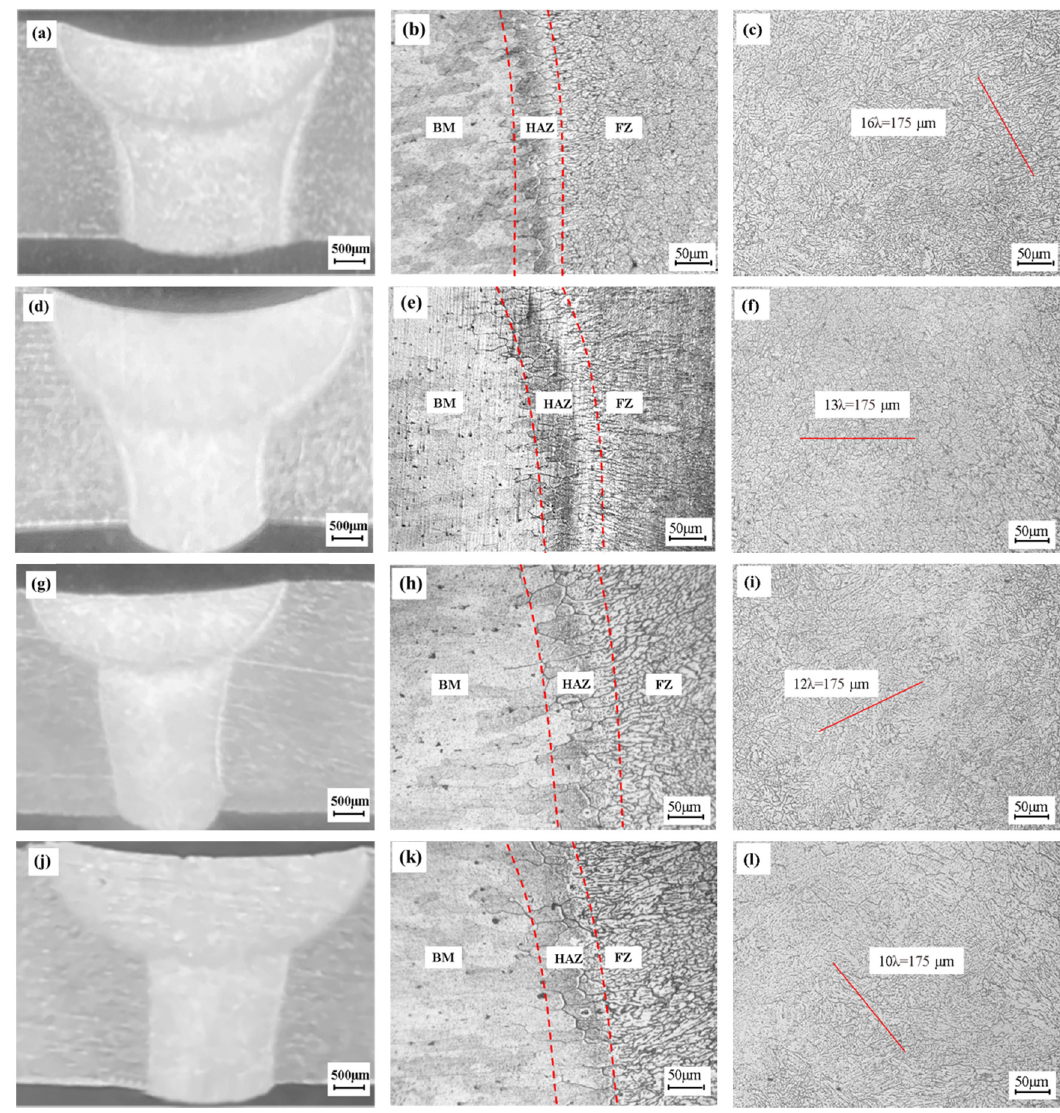
Figure 3: Cross section morphology and microstructure of welded joint under di ff erent conditions: ( a – c ) AW joint, ( d – f ) HT1 joint, ( g – i ) HT2 joint, and ( j – l ) HT3 joint.